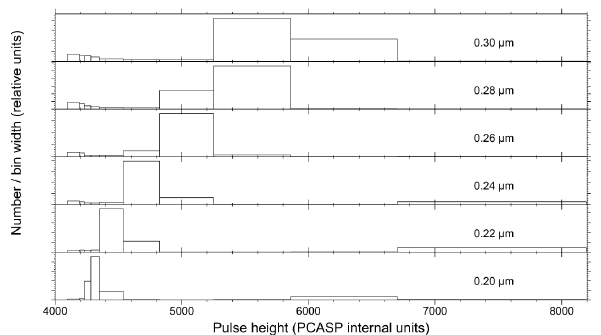
Fig. 6. An example scanning calibration result using a DMA with a PCASP. Each curve represents one bin boundary and is an un- weighted fit to the data points. They show how the fraction of parti- cles bigger than a boundary, F , increase as the DMA mode diame- ter, D ∗ , increases. The value of D ∗ at which a best fit curves crosses 0.5 defines the boundary’s equivalent diameter. Multiply charged particles from the DMA were screened out during the data analysis. The uncertainty in D ∗ is ∼